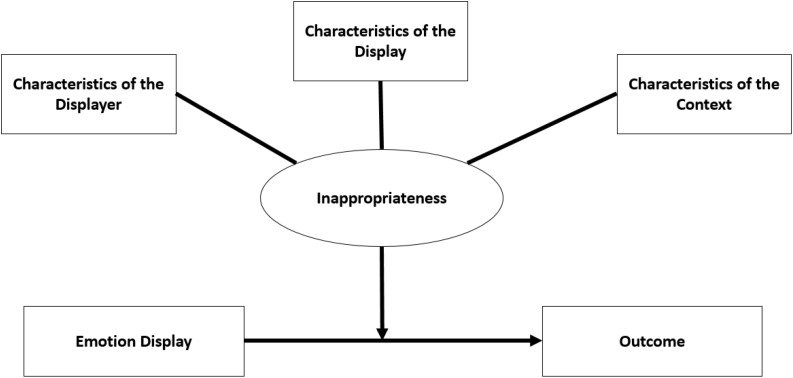
Theoretical model.